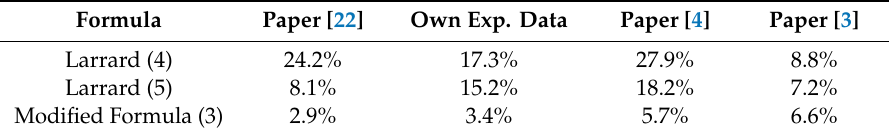
Table 6. Average di ff erences in the results for [3,4,22] and our own experimental data. Formula Paper [22] Own Exp.